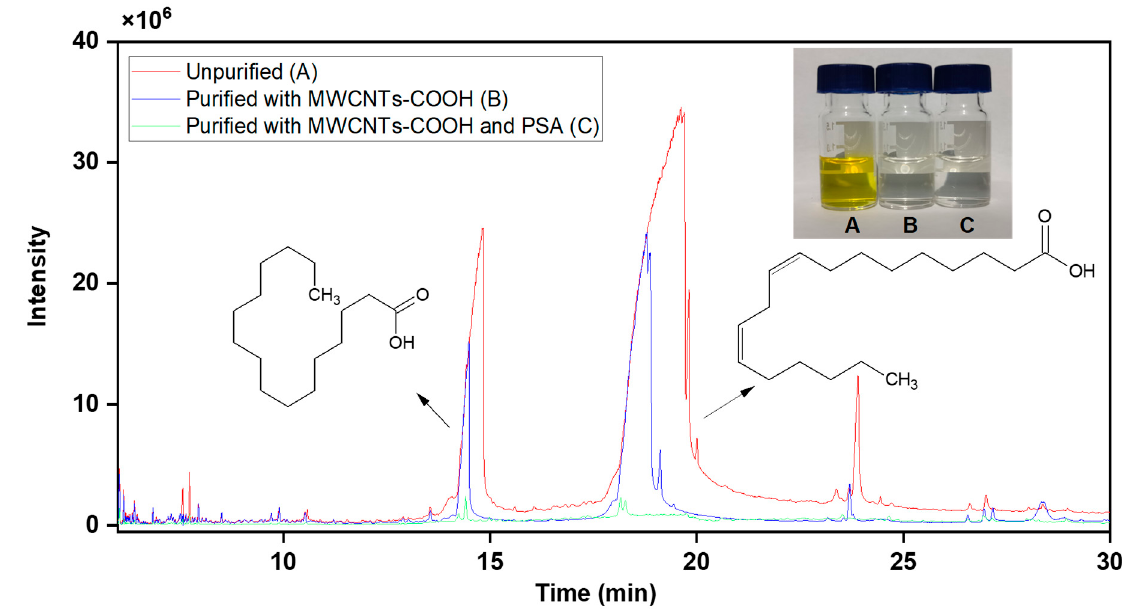
Figure 4. Comparison of GC-MS total ion chromatograms of corn extracts purified with different adsorbents. ( A ) unpurified, ( B ) purified with MWCNTs-COOH, and ( C ) purified with MWCNTs- COOH and PSA.